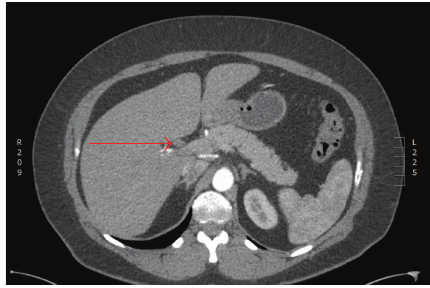
Figure 2: Contrast-enhanced computed tomography (CT) scan demonstrating an arterially enhancing filling defect within the proximal hepatic duct (marked with red